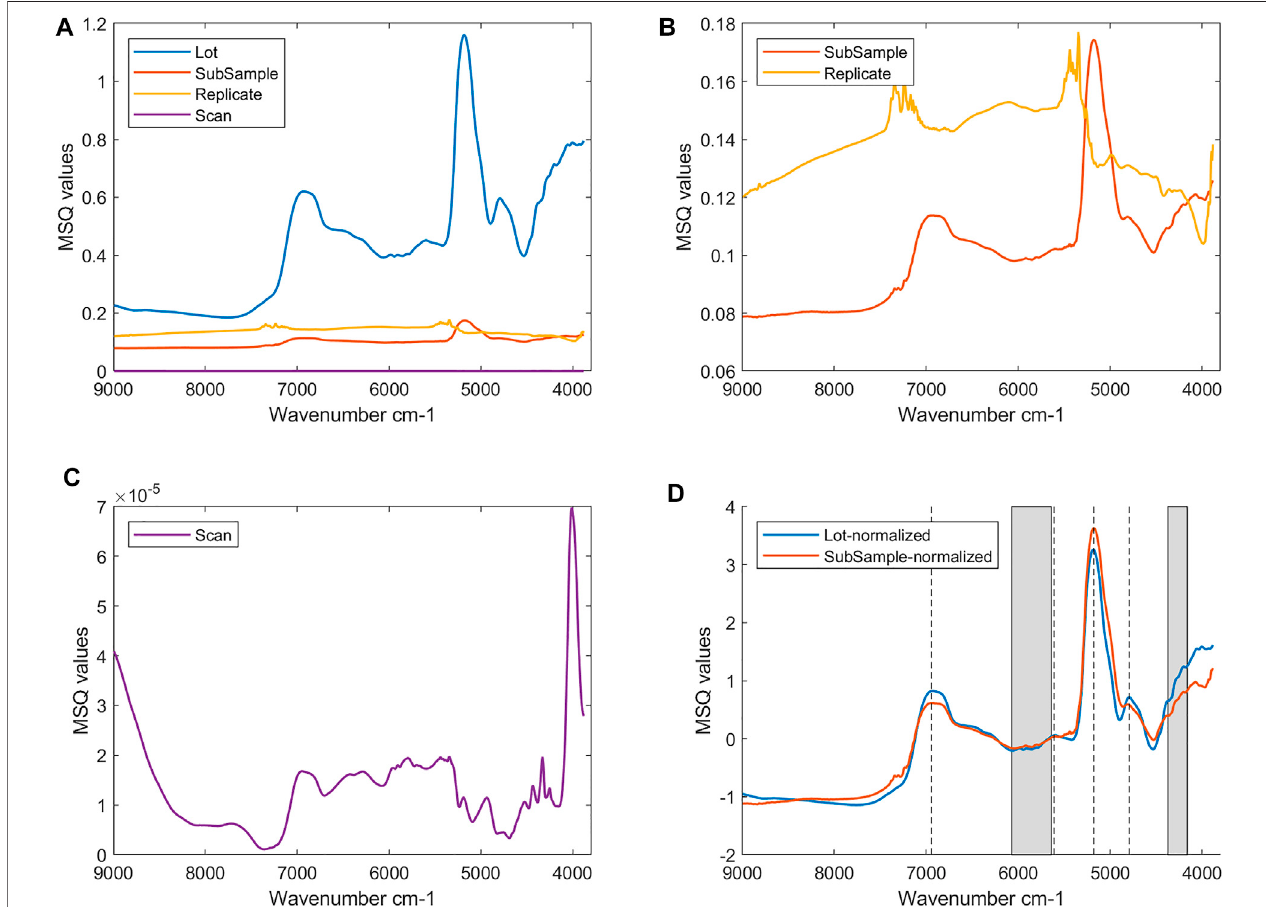
FIGURE3| TheMSQvaluesofthenestedANOVA: (A) allsamplinglevels, (B) onlysubsampleandreplicatelevels, (C) onlyscanlevel,and (D) thenormalized MSQ values at the lot and subsample sampling levels (the grey areas highlight the spectral areas mostly associated with glue compounds).